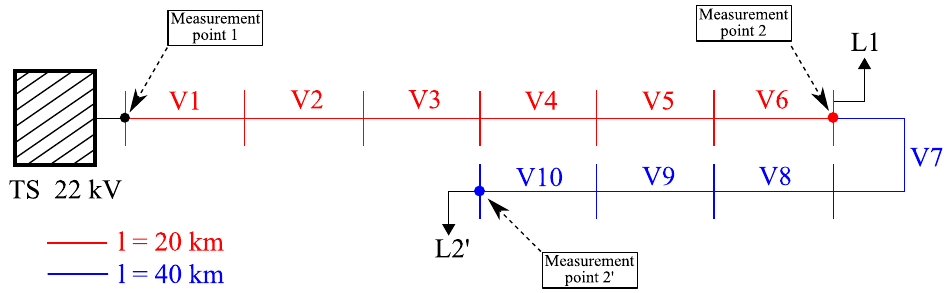
Figure 19. The graphic dependence of increasing APLs from power factor (PF): ( a ) the length of 20 km; ( b ) the length of 40 km . Figure 18. Distribution grid for the analysis of the influence of individual Figure 18. Distribution grid for the analysis of the influence of individual factors.